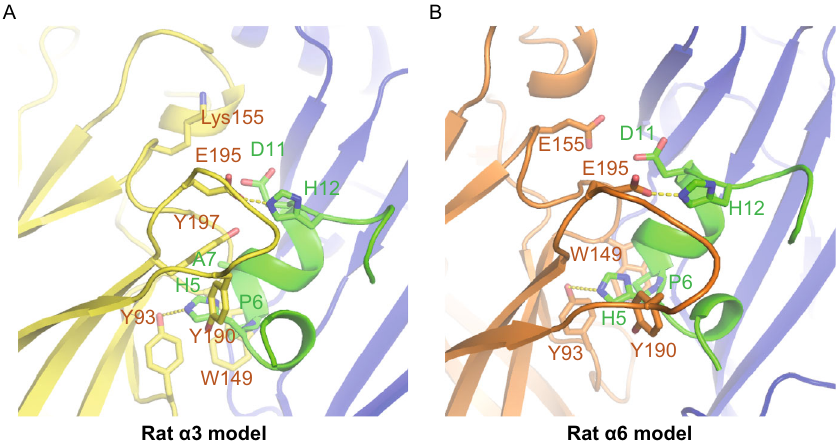
Figure 4. Homology modelling of rat α 3 and rat α 6 bound with α -conotoxin LvIA using Ac-AChBP/LvIA as the template. (A) In the rat α 3 homology model, the Pro-6 of α -CTx LvIA exhibits very strong hydrophobic interactions with the Trp-149 of α 3 and Trp-57 of β 2 subunit both on the principal and complementary binding side; His-5 of LvIA has a hydrogen bond with Tyr-193 and widely hydrophobic interactions with Tyr-93, Tyr-190, and Tyr-197 of α 3 subunit; Ala-7 exhibits hydrophobic interactions with Trp-149, Tyr- 151, and Tyr-197 of α 3 subunit and His-12 of LvIA forms a salt bridge with Glu-195 of α 3 subunit. (B) In the rat α 6 homology model, contacts were very similar with the α 3 model except Lys-155 in α 3 subunit is replaced by Glu-155 and cause an electrostatic repulsion with Asp-11 of LvIA.